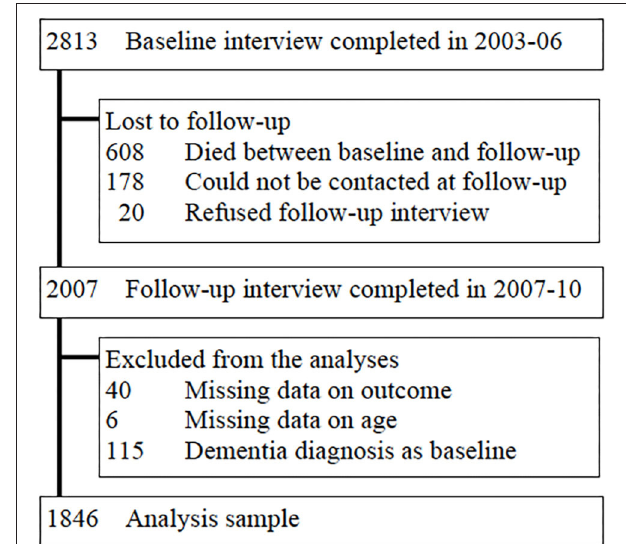
FIGURE 1 | Flow chart. Describing the flow of participants in the study, attrition, and selection of participants in the analyses sample.